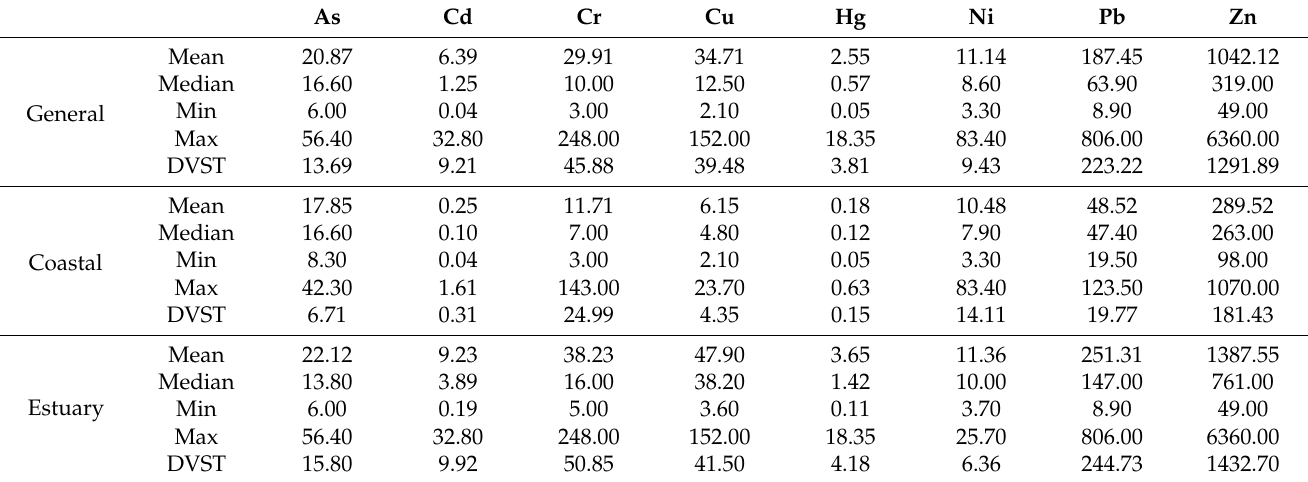
Table 1. Statistical summary of the metal(loid) concentrations in the study